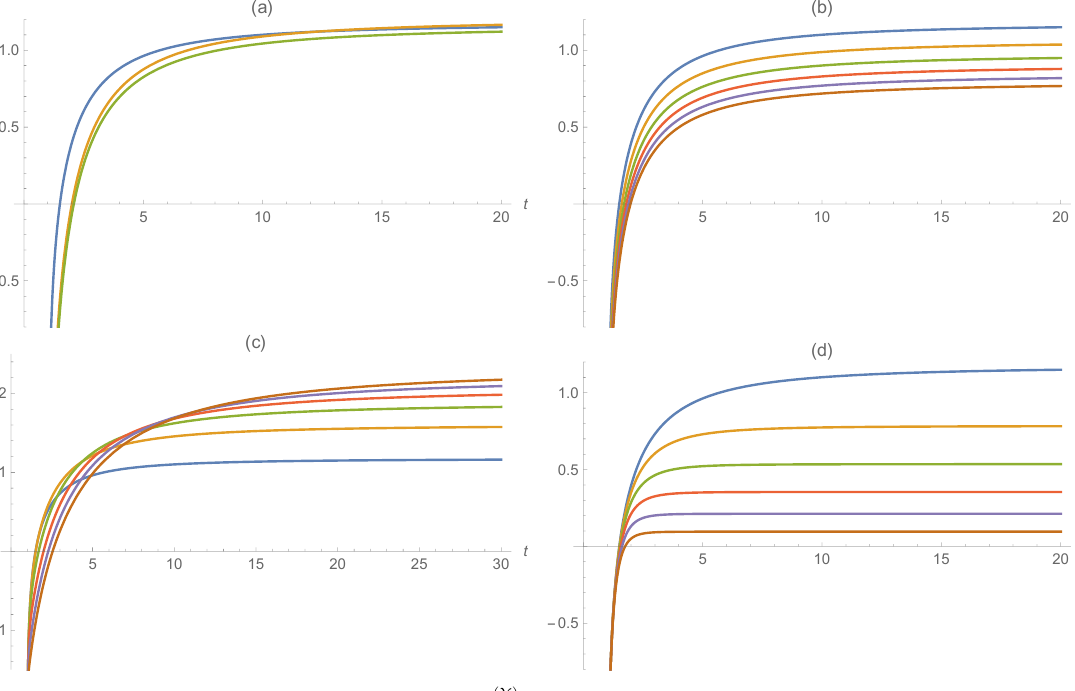
( Y ) Figure 6. Plots of the differential entropy of X for the case considered in Example 4, for u = 1, and u , t ( a ) α = 2, β = 2, µ = 1, with λ = 1, 2, 3 (from top to bottom near t = 5); ( b ) λ = 1, β = 2, µ = 1, with α = 2, 3, 4, 5, 6 (from top to bottom); ( c ) λ = 1, α = 2, β = 2, with µ = 1, 2, 3, 4, 5, 6 (from bottom to top for large t ); ( d ) λ = 1, α = 2, µ = 1, with β = 2, 3, 4, 5, 6, 7 (from top to